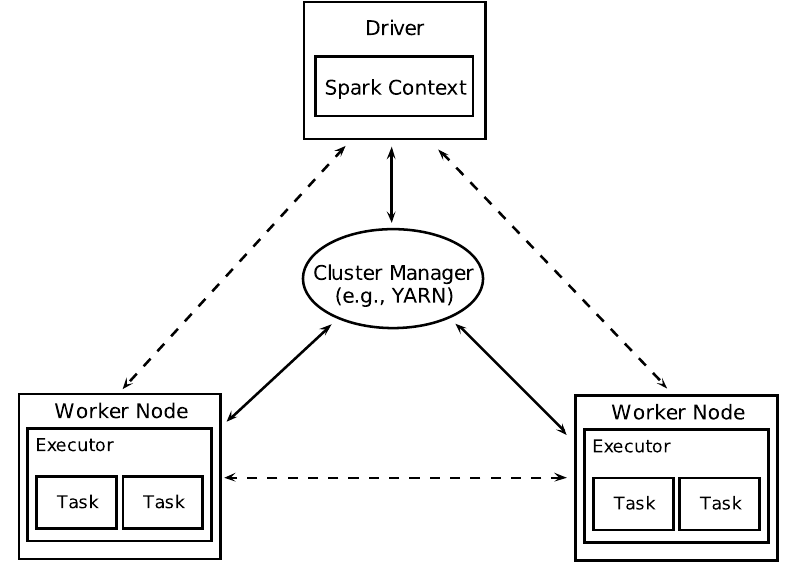
Figure 2. Apache Spark